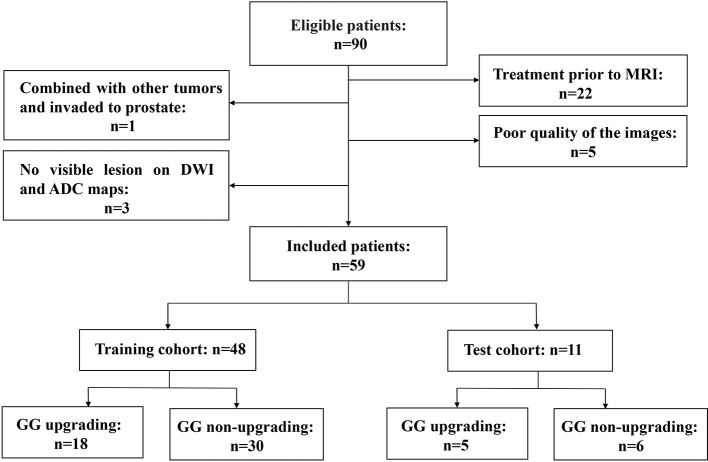
Flow chart of inclusion and exclusion criteria for patients.